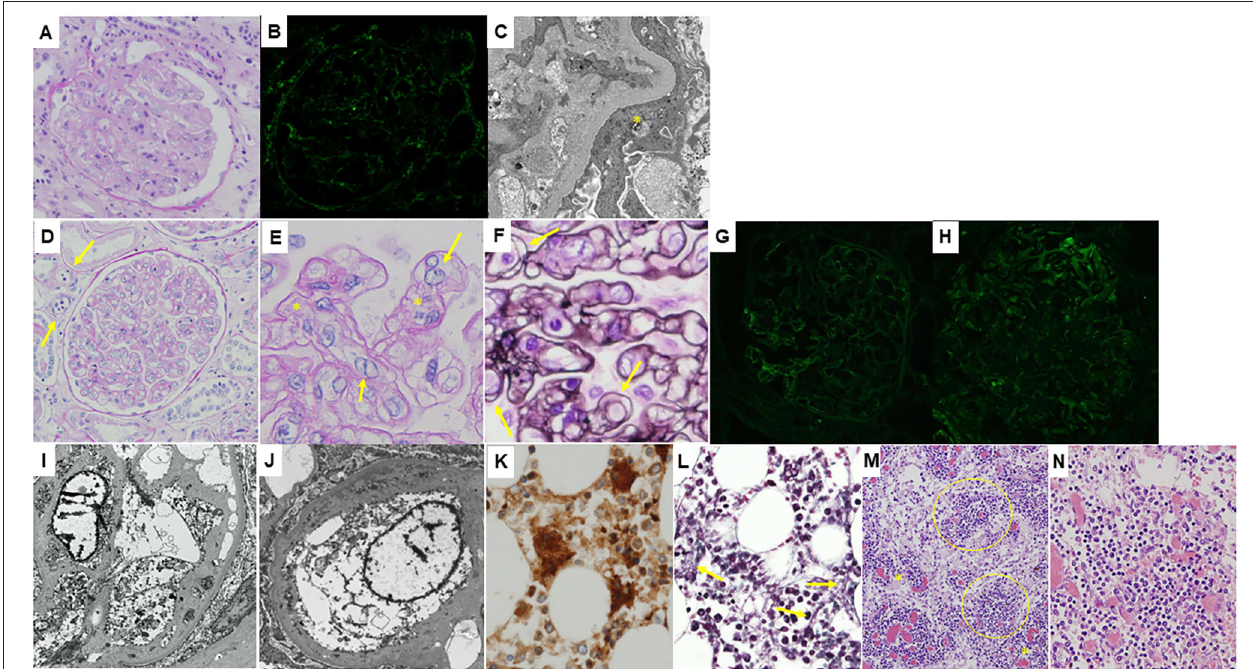
FIGURE 1 | Histological features of the patient. (A–C) : Microphotographs of the native kidney. (A) Light microscopy image of a periodic acid-Schiff-stained section showing mesangial proliferation and thickening of the glomerular capillary walls, i.e., membranoproliferative glomerulonephritis pattern. Swelling of glomerular endothelial cells is also seen. (B) Immunofluorescence staining for immunoglobulin G showing only faint deposition in the glomeruli. (C) An electron microscopy section showing no obvious electron-dense deposits. Podocyte foot process effacement is shown (yellow asterisk). (D–N) : Microscopic findings of the autopsy samples. (D) Light microscopy image of a periodic acid-Schiff-stained transplanted kidney section showing prominent swelling of glomerular endothelial cells, mesangiolysis, and duplication of the glomerular capillary walls suggesting thrombotic microangiopathy. Peritubular capillaritis is also shown (yellow arrows). A